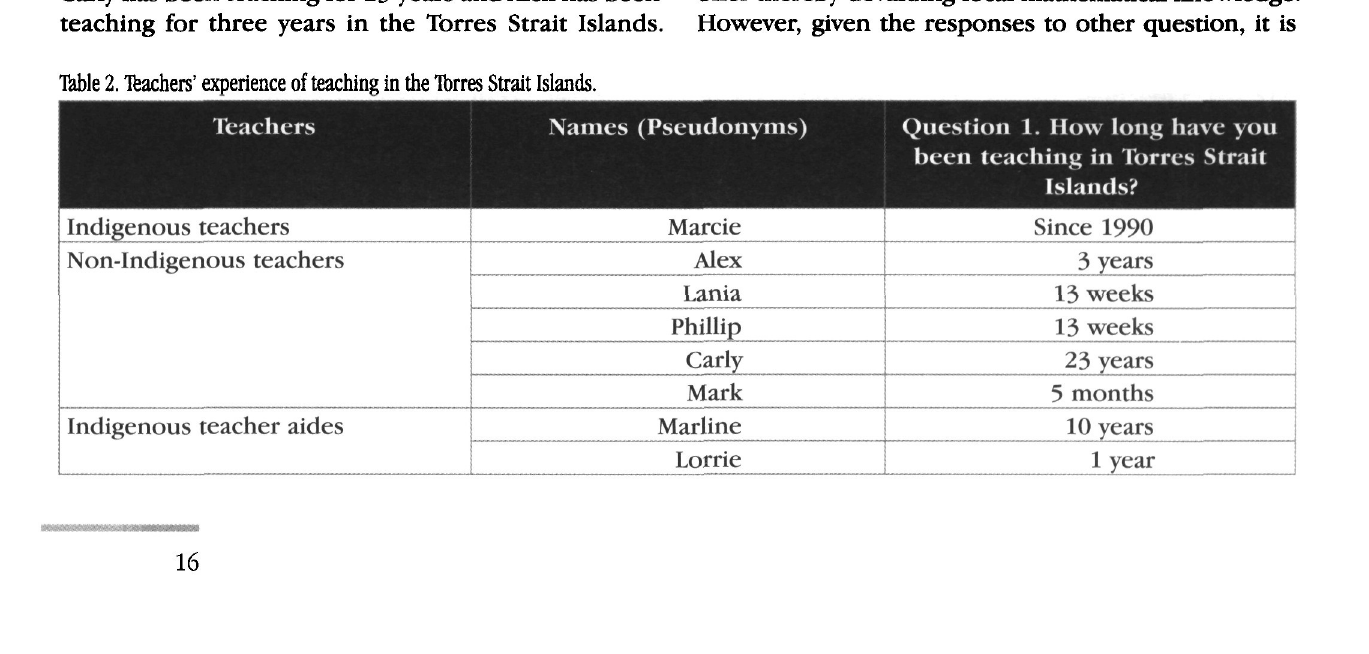
Table 2. "teachers' experience of teaching in the Tbrres Strait